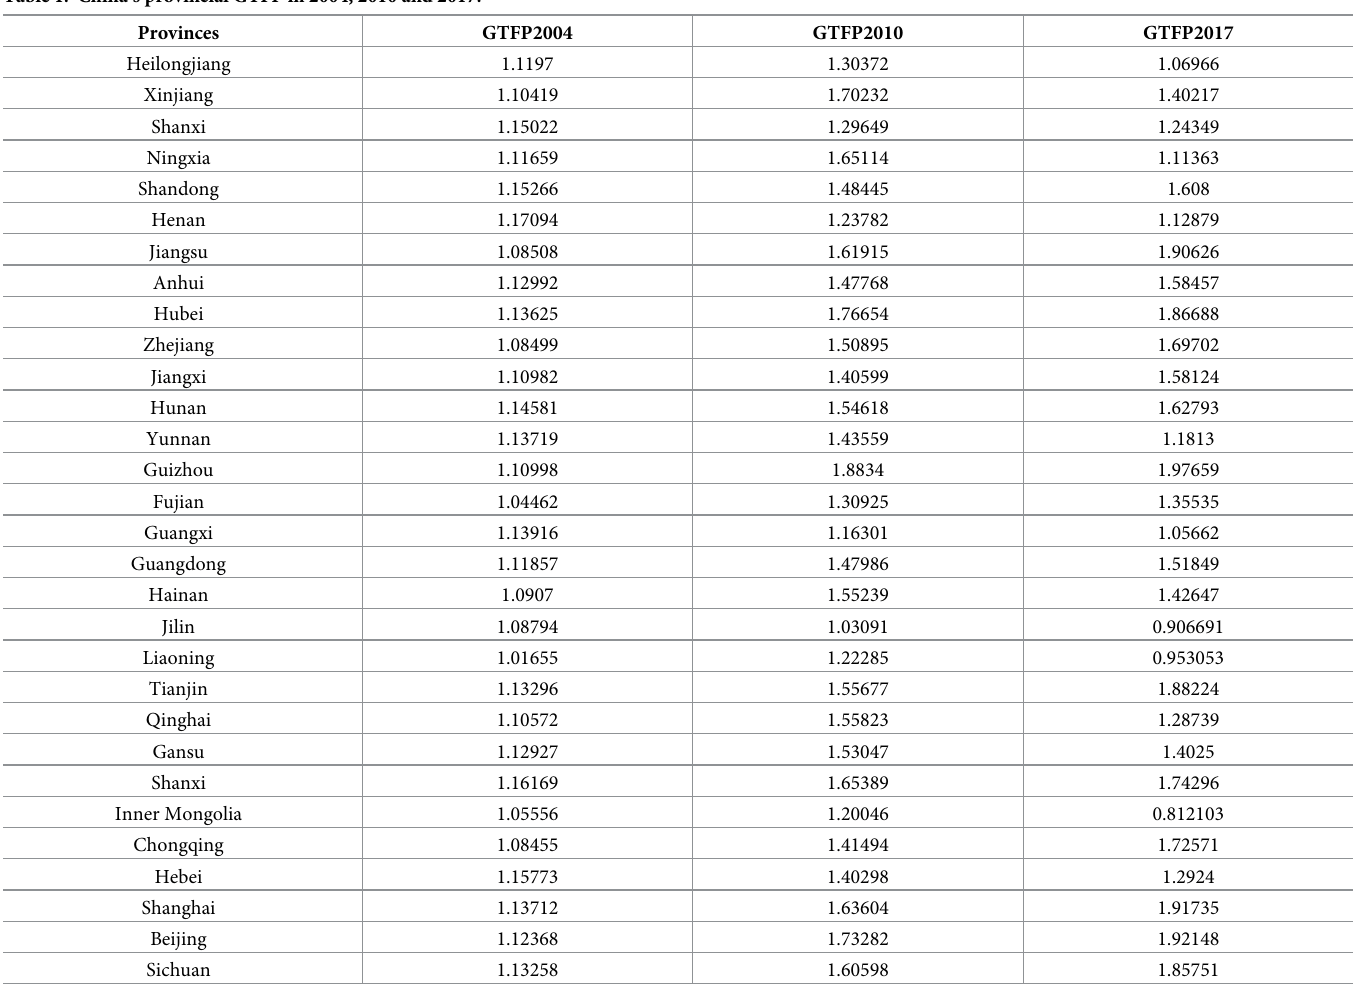
Table 1. China’s provincial GTFP in 2004, 2010 and